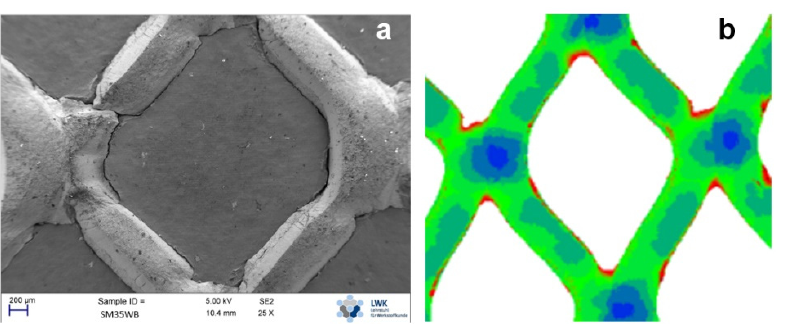
Figure 7. Images of inlay failure after roll bonding: ( a ) according to [23], where failure was caused by the use of non-annealed expanded mesh; ( b ) localized deformation in the annealed mesh inlay as a consequence of the elevated length of the deformation zone in the “duo” mill (see Table 1, experiment code d40).